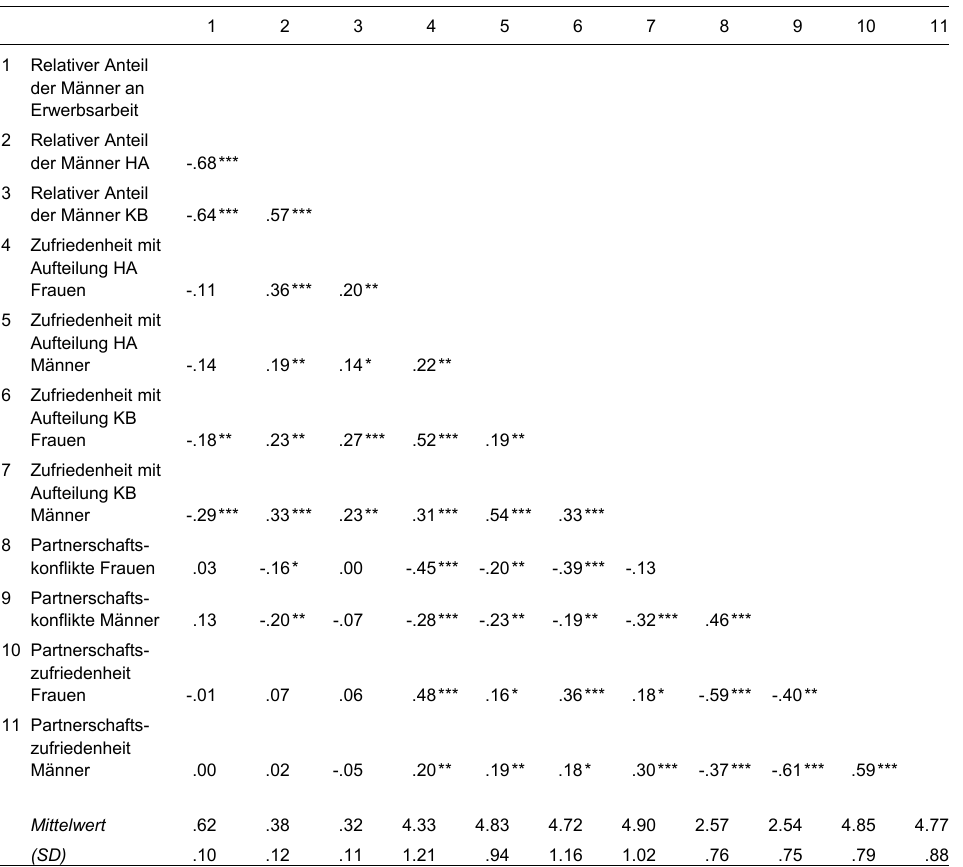
Tabelle 1 : Korrelationen, Mittelwerte und Standardabweichungen der